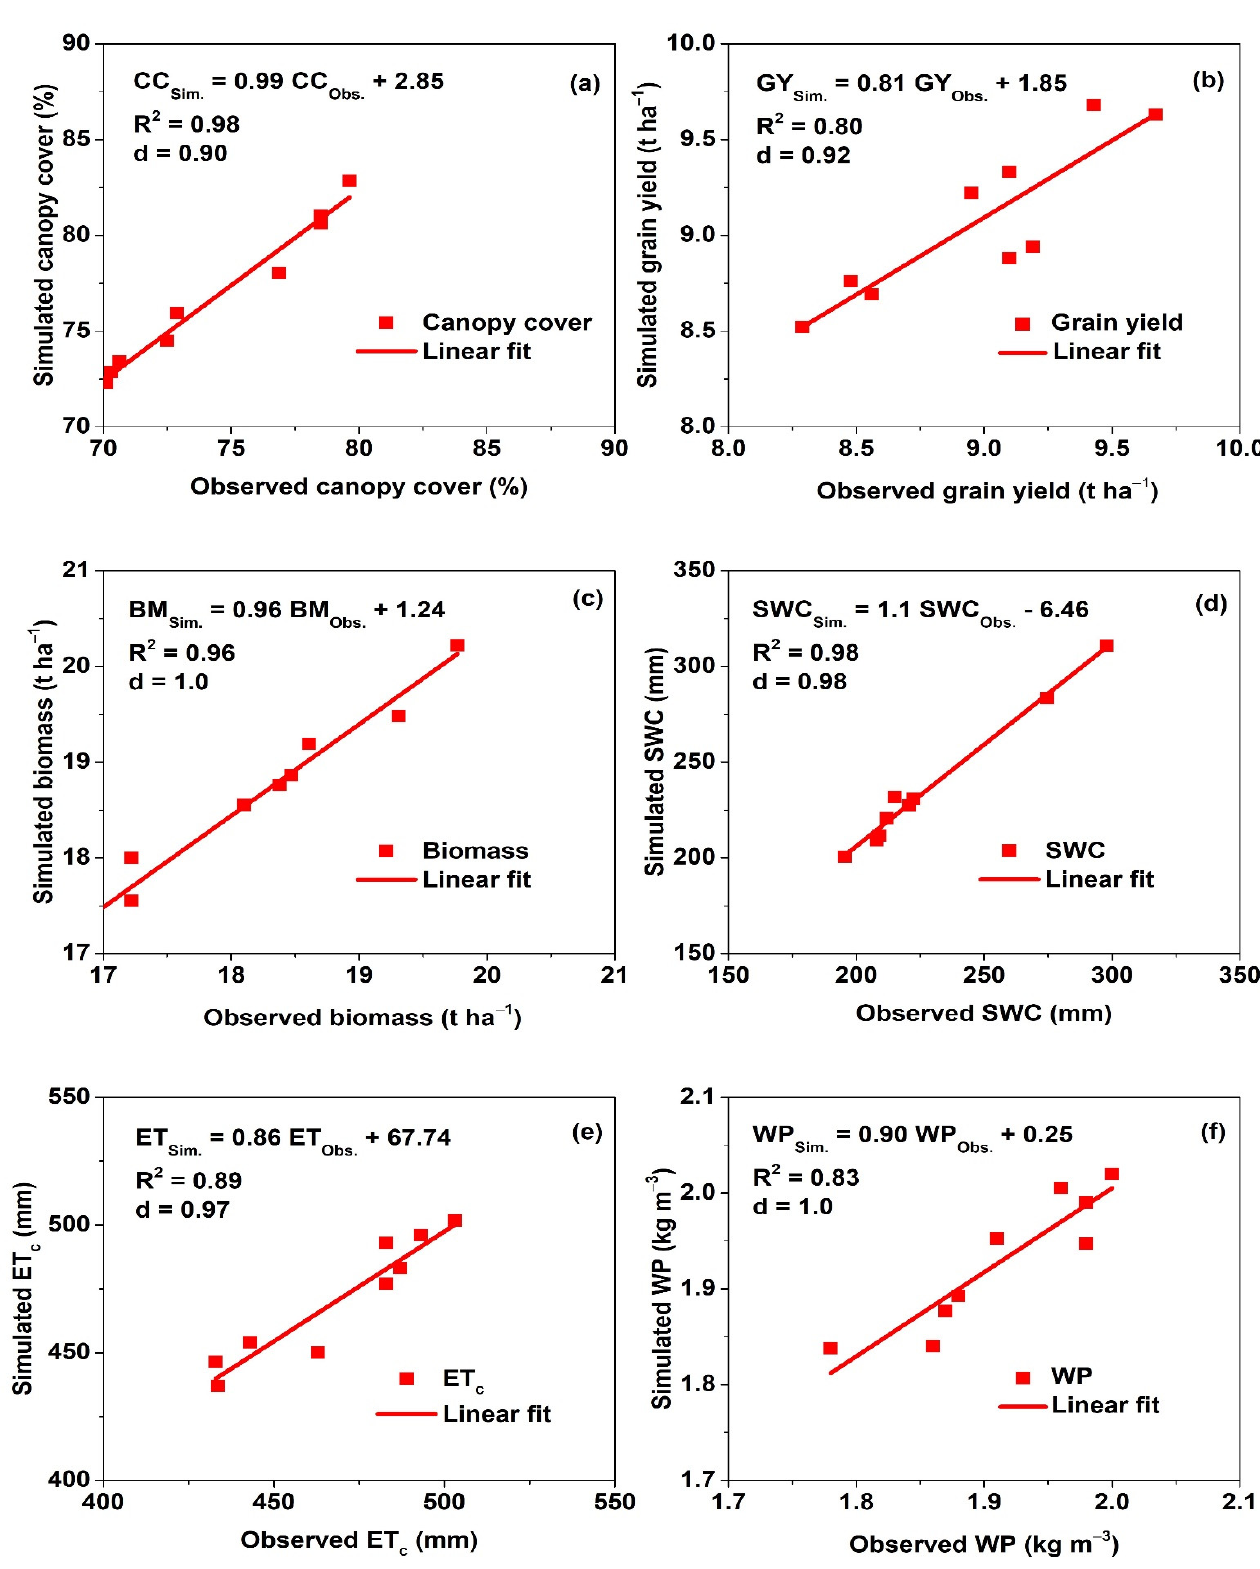
Figure 4. The relation between observed and simulated values for canopy cover ( a ), grain yield ( b ), biomass ( c ), soil water content SWC ( d ), crop evapotranspiration ET c ( e ), and water productivity WP ( f ) under all treatments in 2016 − 2017 under model calibration.